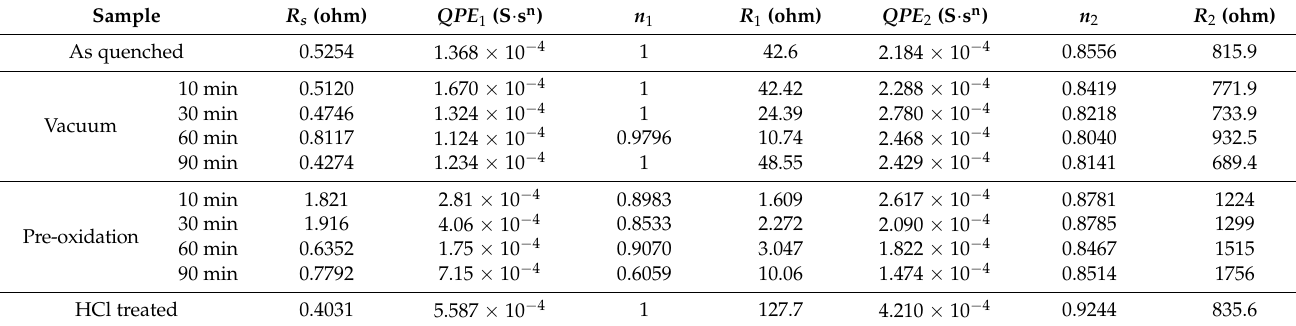
Table 1. Impedance curve fitting